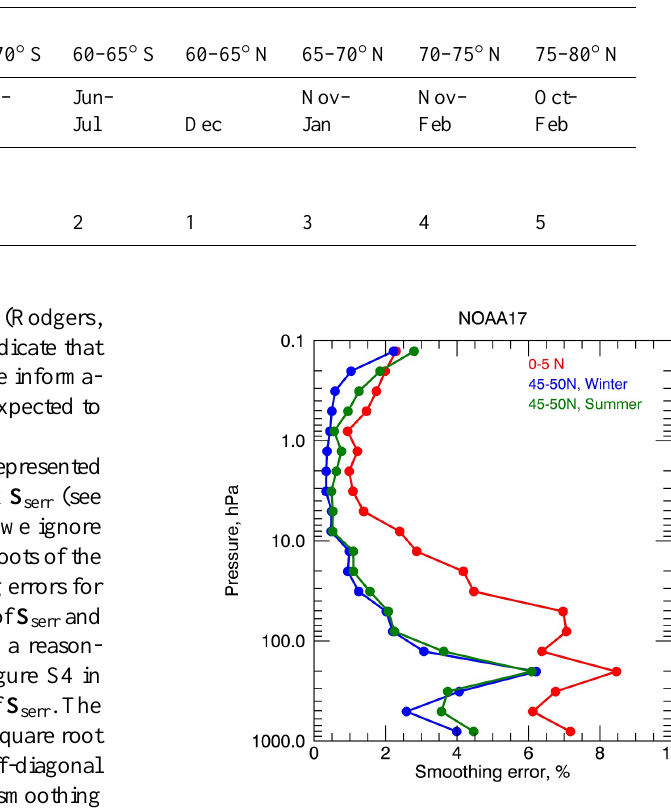
Fig. 5. Typical profiles of SBUV smoothing error (% from the mean a priori profile) for the northern midlatitudes in summer (green line), in winter (blue line) and for the tropics (red line). Profiles from NOAA 17, January and July